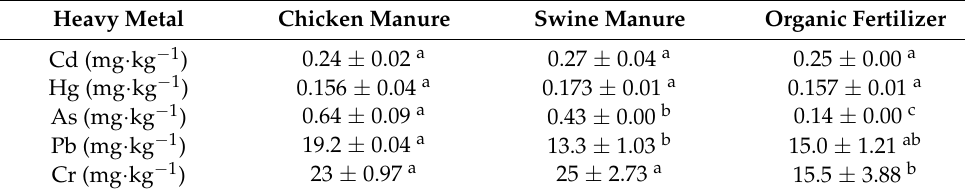
Table 2. Heavy metal concentrations in chicken manure, swine manure, and organic fertilizer. Heavy